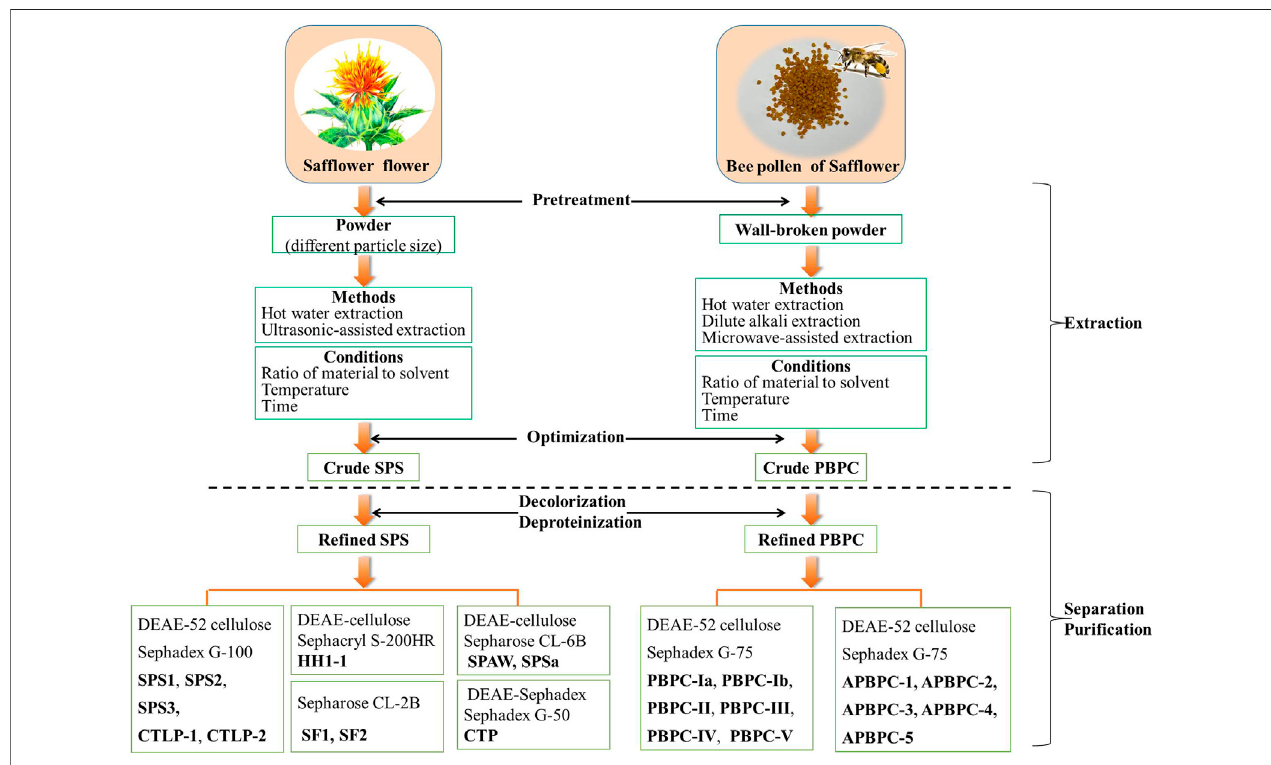
FIGURE 2 | Schematic representation of the extraction and puri fi cation of polysaccharides from the fl ower and bee pollen of saf fl ower (SPS: Saf fl ower polysaccharides; PBPC: Polysaccharides of saf fl ower bee pollen).